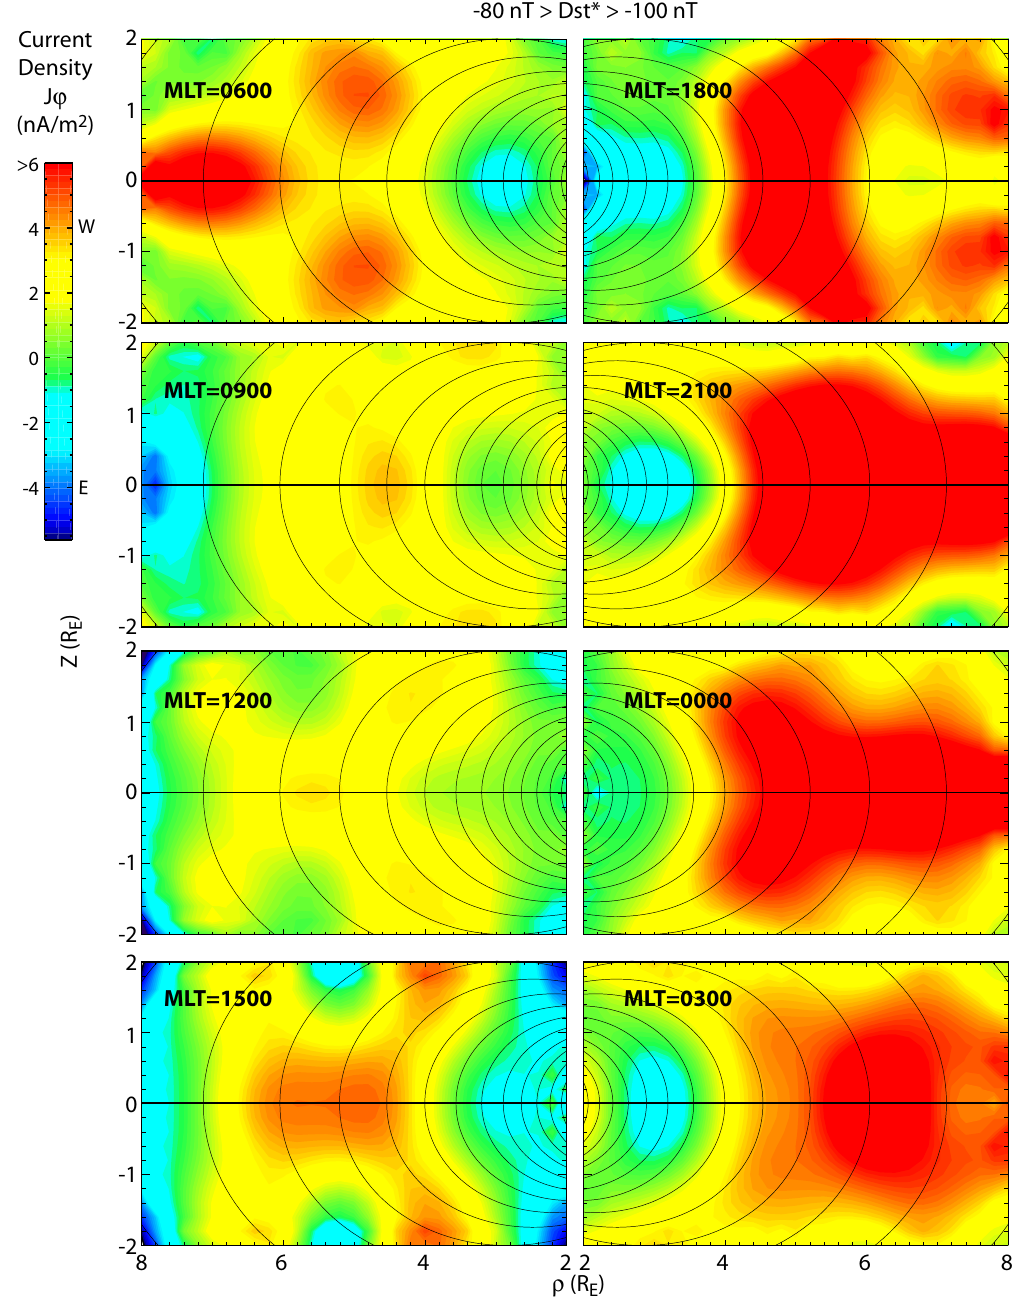
Fig. 6d. Azimuthal component of the current density (or the ring current density) with superimposed dipole field lines for each of the four D st * levels: d) − 80nT >D st * > −